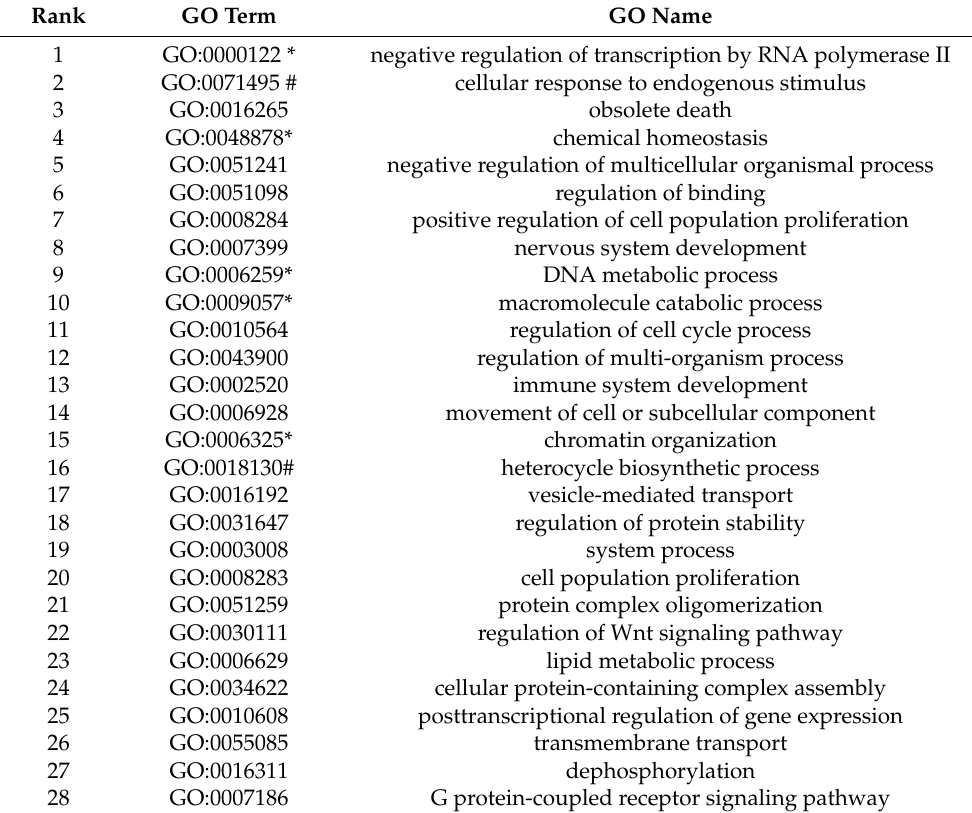
Table 3. The rank of GO terms according the predictions of ReprsentConcat. The GO terms marked with the character ‘#’ indicate that they have been confirmed in the annotation datasets, and the GO terms marked with the character ‘*’ represent they are new annotations for 2017 from UniProt-GOA.